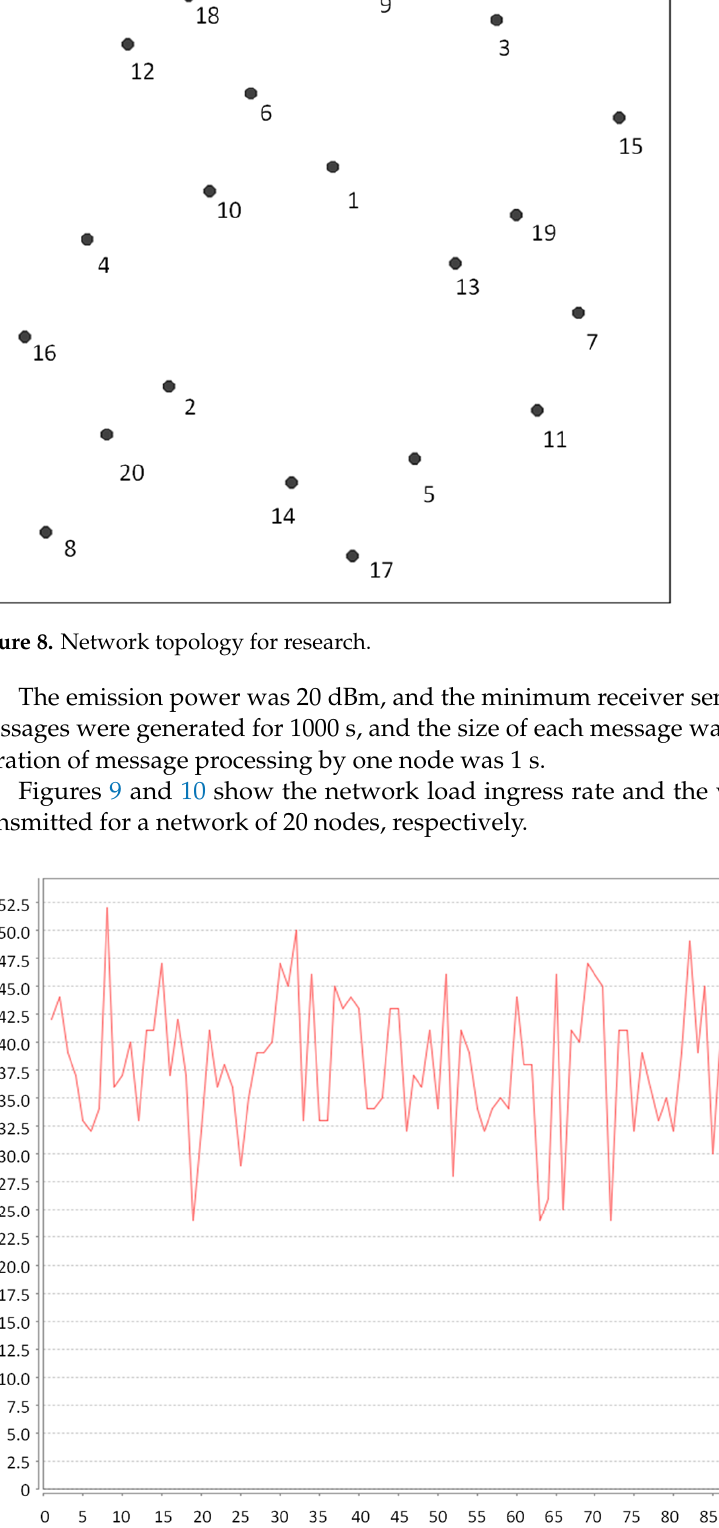
Figure 9. Intensity of the incoming load.